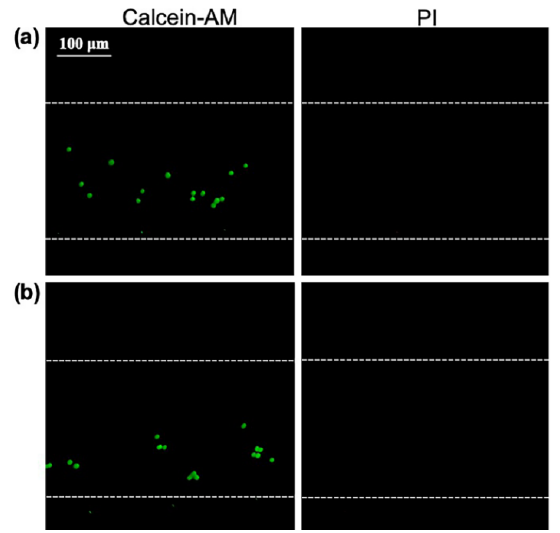
Figure 7. The extent of cell death. ( a ) The fluorescence images of MCF-7 after 3 min sonication, where the cell is excited by the PZT at frequency of 400 kHz. ( b ) The fluorescence images of MCF-7 with no acoustic excitation. acoustic